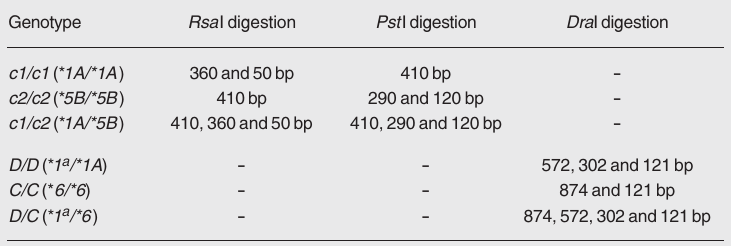
Table 2. Size of the digestion products according to CYP2E1 genotype and different restriction enzymes used in their analysis.